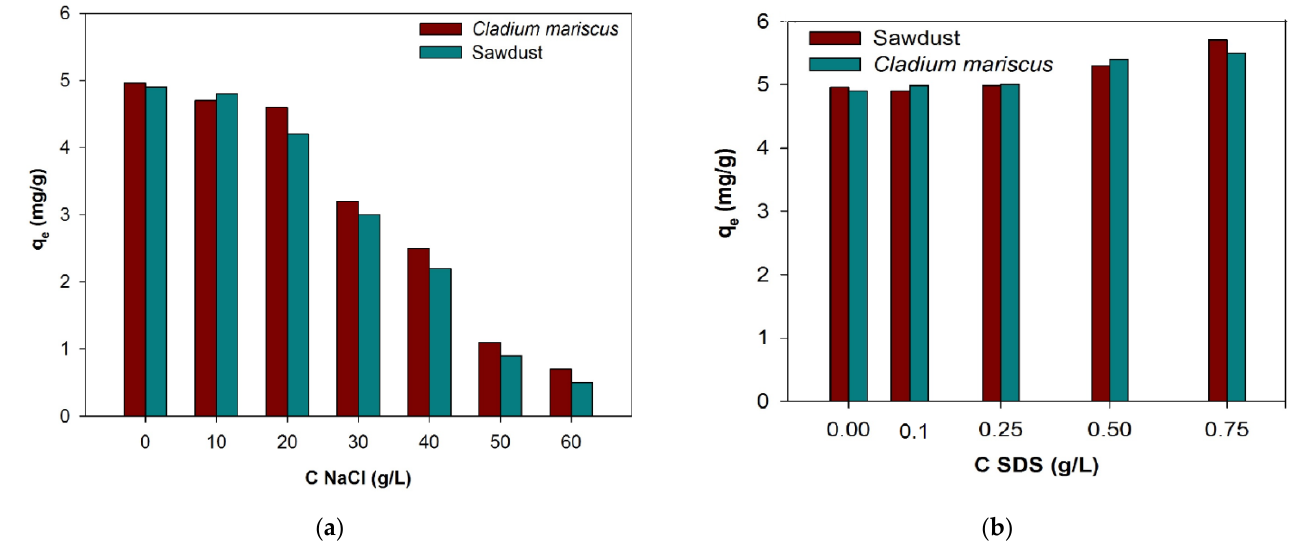
Figure 8. Influence of ( a ) NaCl and ( b ) SDS concentration on BB3 uptake by sawdust and Cladium mariscus saw-sedge.